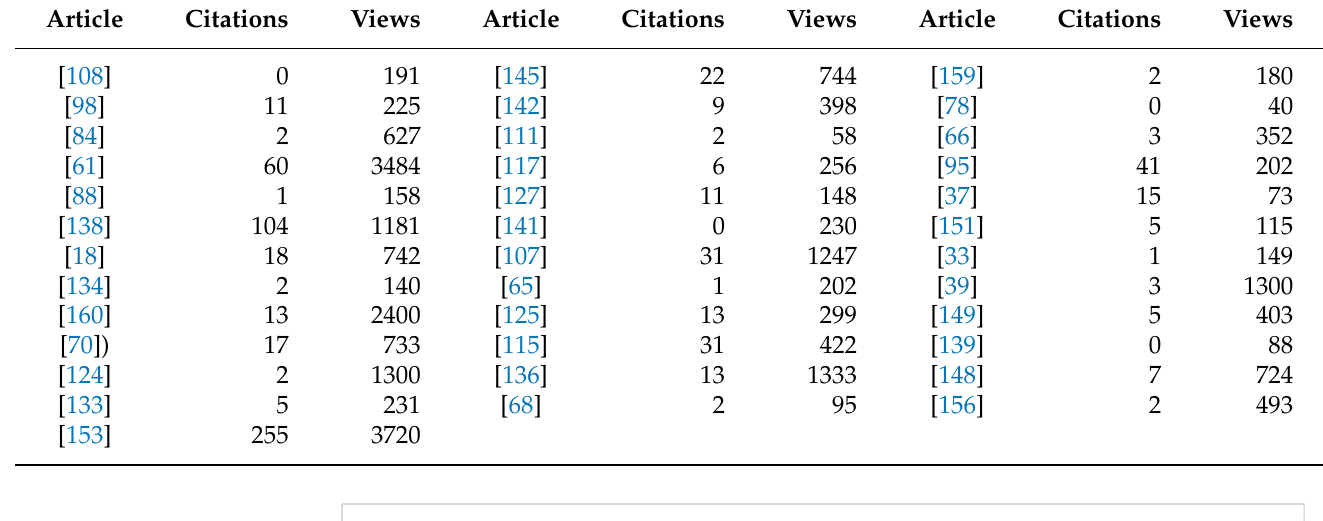
Table 7. Number of citations and readings of publications related to AH.